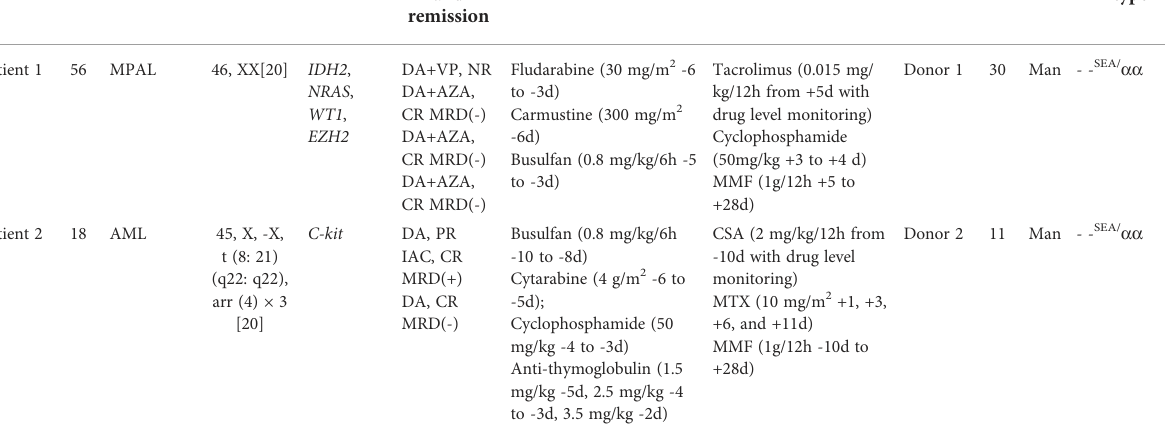
TABLE 1 The clinic characteristics of patients and donors. Patients Age Diagnosis Karyotype Mutation Treatment